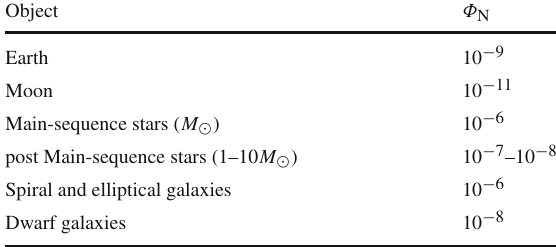
Table 1 Astrophysical objects of interest and their Newtonian potentials